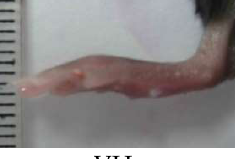
Figure 1. Zymosan A-induced infiltration of inflammatory cells into draining pLNs (VH: control group injected zymosan A only) and the effect on pLN reduction by the compounds. The anti-inflammatory drug dexamethasone was employed as a positive control. Samples were administered by IP from day 0 to day 6. On day 7, pLNs were isolated and weighed. ** p < 0.01 compared with the group treated with the LPS alone. Data are presented as the mean ± SD.